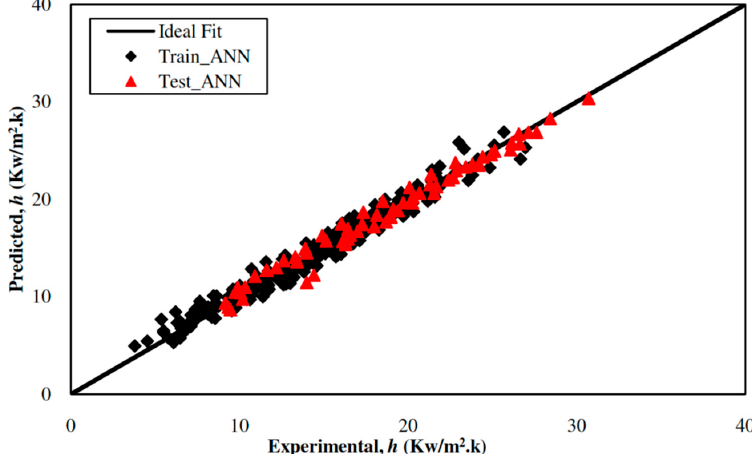
Figure 3. ANN model performance assessment using the training and test dataset. Table 2. Evaluation of the ANN-based model based on statistical parameters.